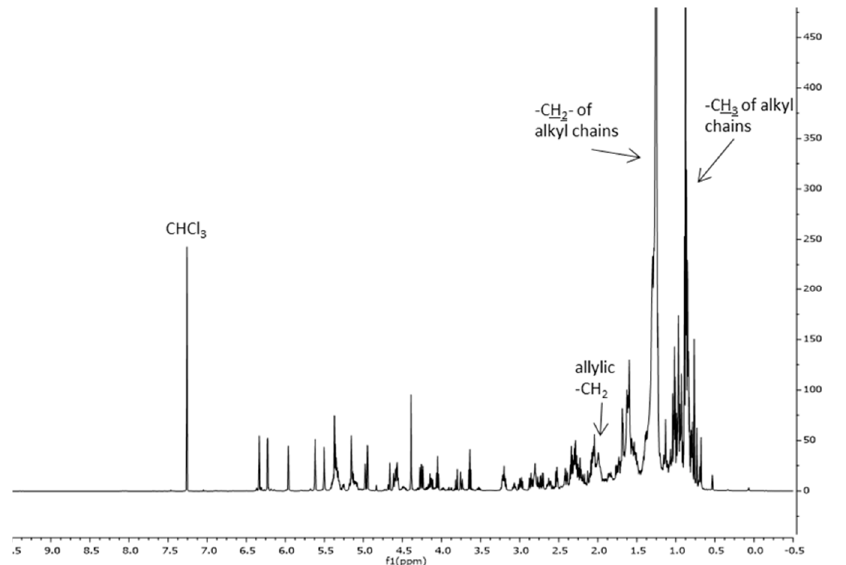
Figure 3. 1 H NMR spectrum of the CLE scCO 2 Sp. 1 H NMR (500 MHz, CDCl 3 ): δ : 0.54, –CH 3 of sterols; δ : 0.69, –CH 2 of triterpenes; δ : 0.85–0.93, –CH 3 of alkyl chains; δ : 1.20–1.42, –CH 2